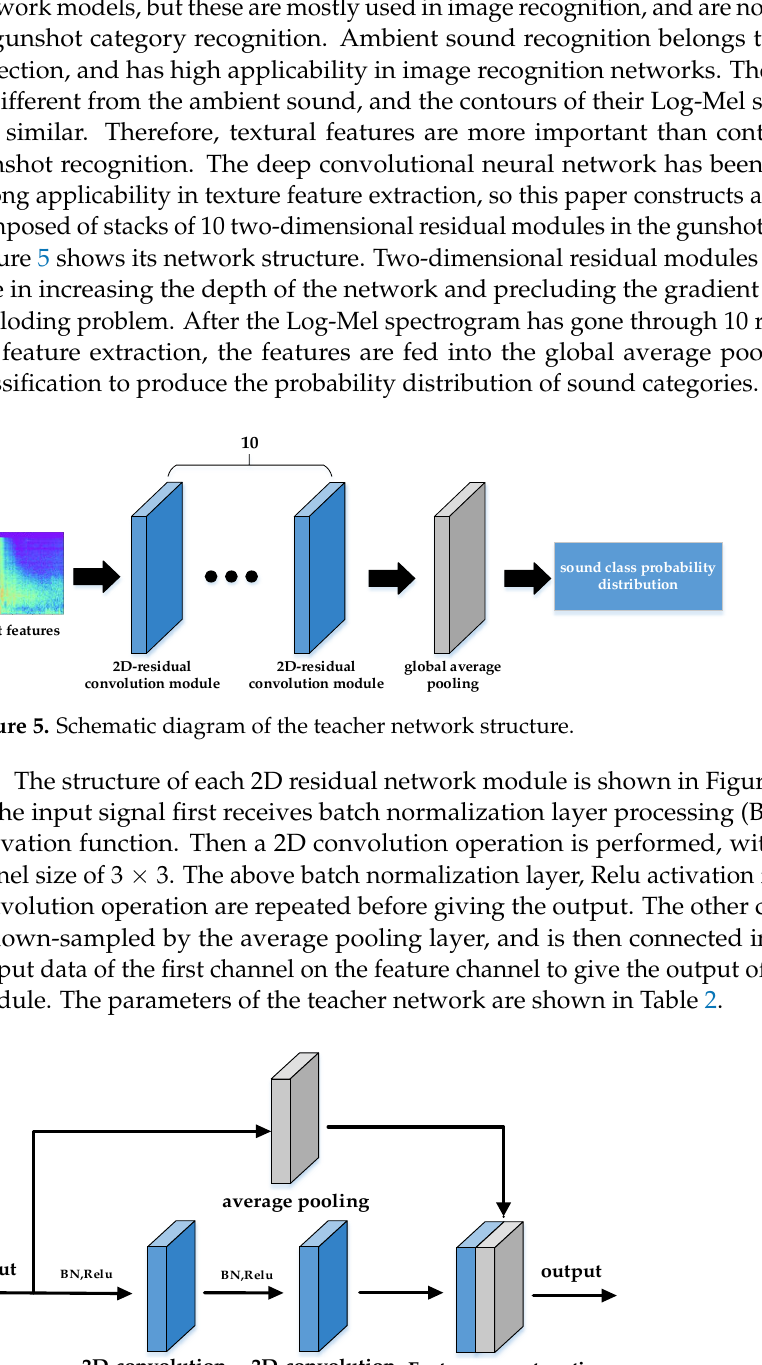
Table 2. Teacher network parameters.